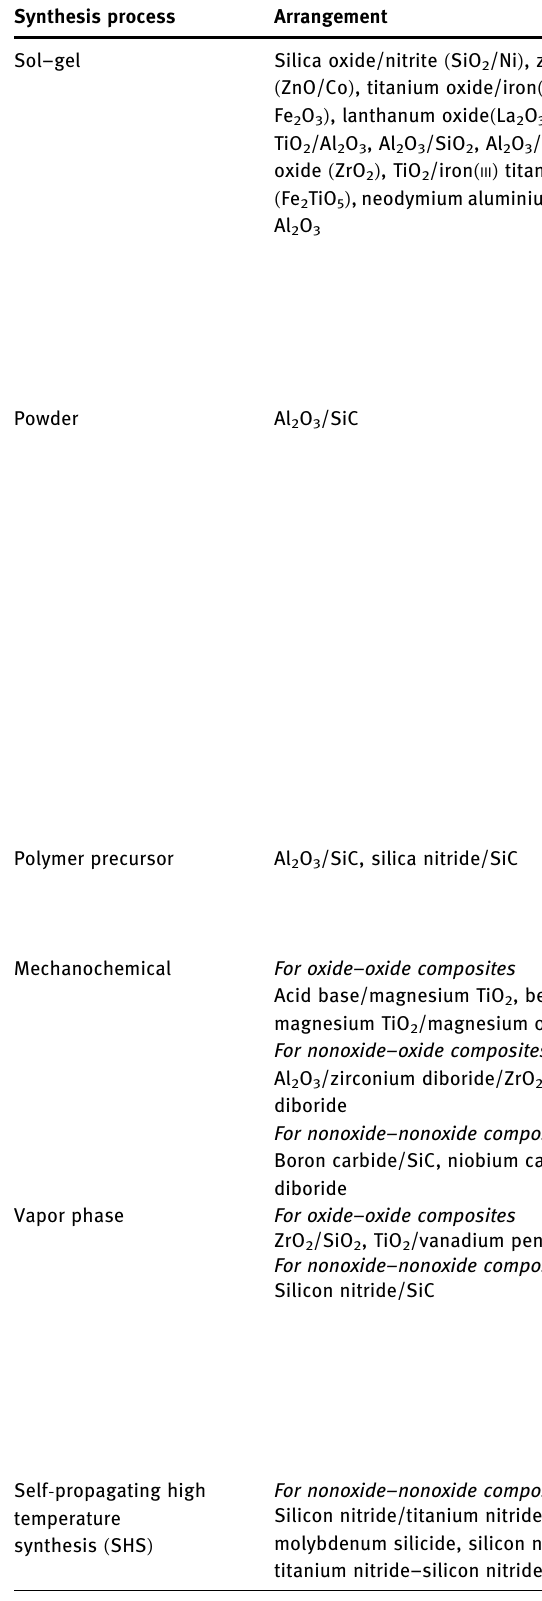
Table 4: Indicating processing stages and synthesis methods for CMNCs Synthesis